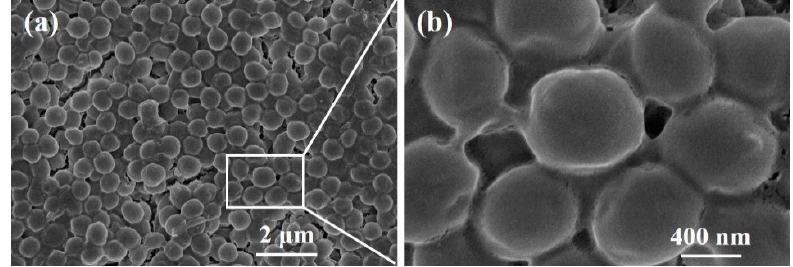
Figure 14. SEM images of a biofilm before debridement: ( a ) 10000×, ( b ) 50000×.